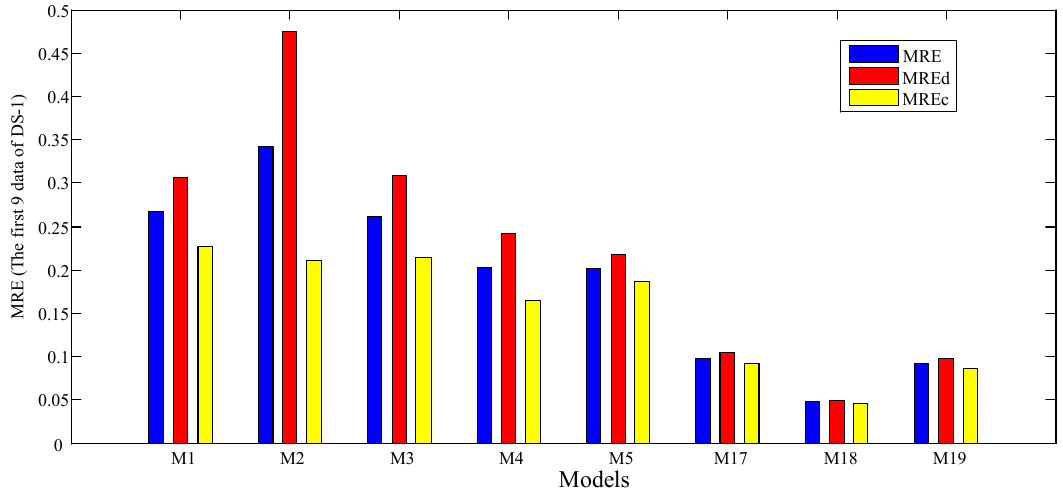
Figure 3. Comparisons of the prediction results based on M1-M5 and M17-M19 for DS-1.